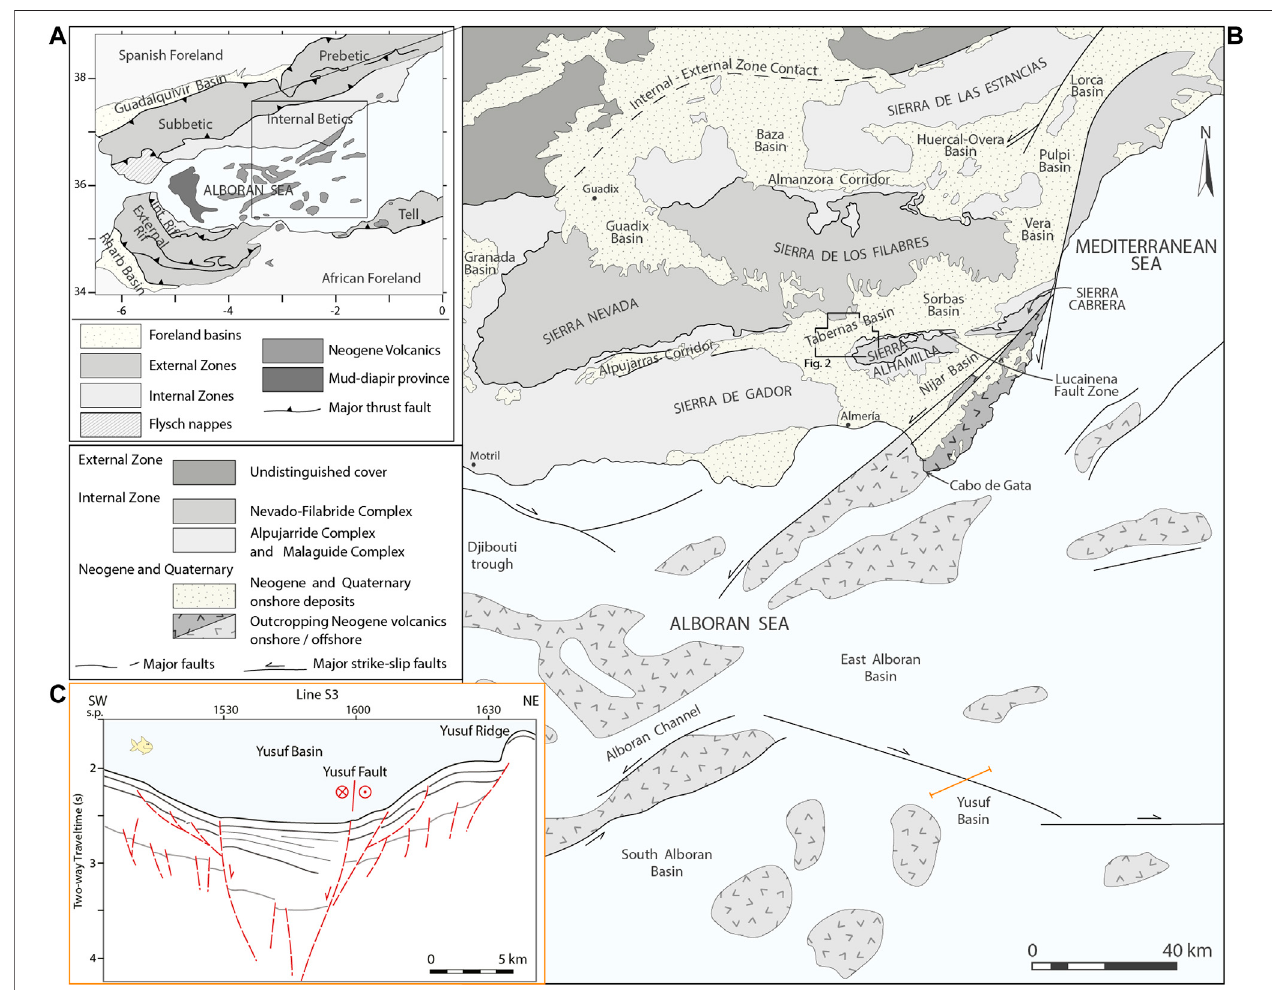
FIGURE 1 | Regional context of the Tabernas Basin (A) Map highlighting the main tectonic domains associated with the Cenozoic Alpine orogeny in the western Mediterranean, including theBetics insouthernSpainand theRif andTell beltsinNorth Africa andthe intervening Alborán Sea,an areaofstretchedcontinental crust (B) Larger-scale outline geological map (see location in A) of the south-eastern Betics and the adjacent Alborán Sea showing the distribution of the main basement blocks, sedimentarybasins,volcanicmassifsandNeogenestrike-slipfaults.Thelocationofthestudyareashowninmoredetailin Figure2 isboxed.Modi fi edfromVissers etal.(1995) andAlvarez-Marrón(1999) (C) SchematicseismiclineinterpretationacrosstheYusufBasin(easternpartoftheAlboránSea;seelocationinB)adapted from Alvarez-Marrón (1999). Asymmetry of the basin fi ll bounded by a pair of sub-vertical faults is clearly shown by the thickening of the succession towards the main dextral oblique-slipYusufFault.Listricextensionalfaultscausedbygravitationalslidingarealsoobservedonthemarginsofthebasin.Faultsarerepresentedindashedred lines; relative shear movement on both sides of the fault is indicated by circles: circle with dot (cid:1) out of page; circle with x (cid:1) into the page. s.p. (cid:1) shotpoints.